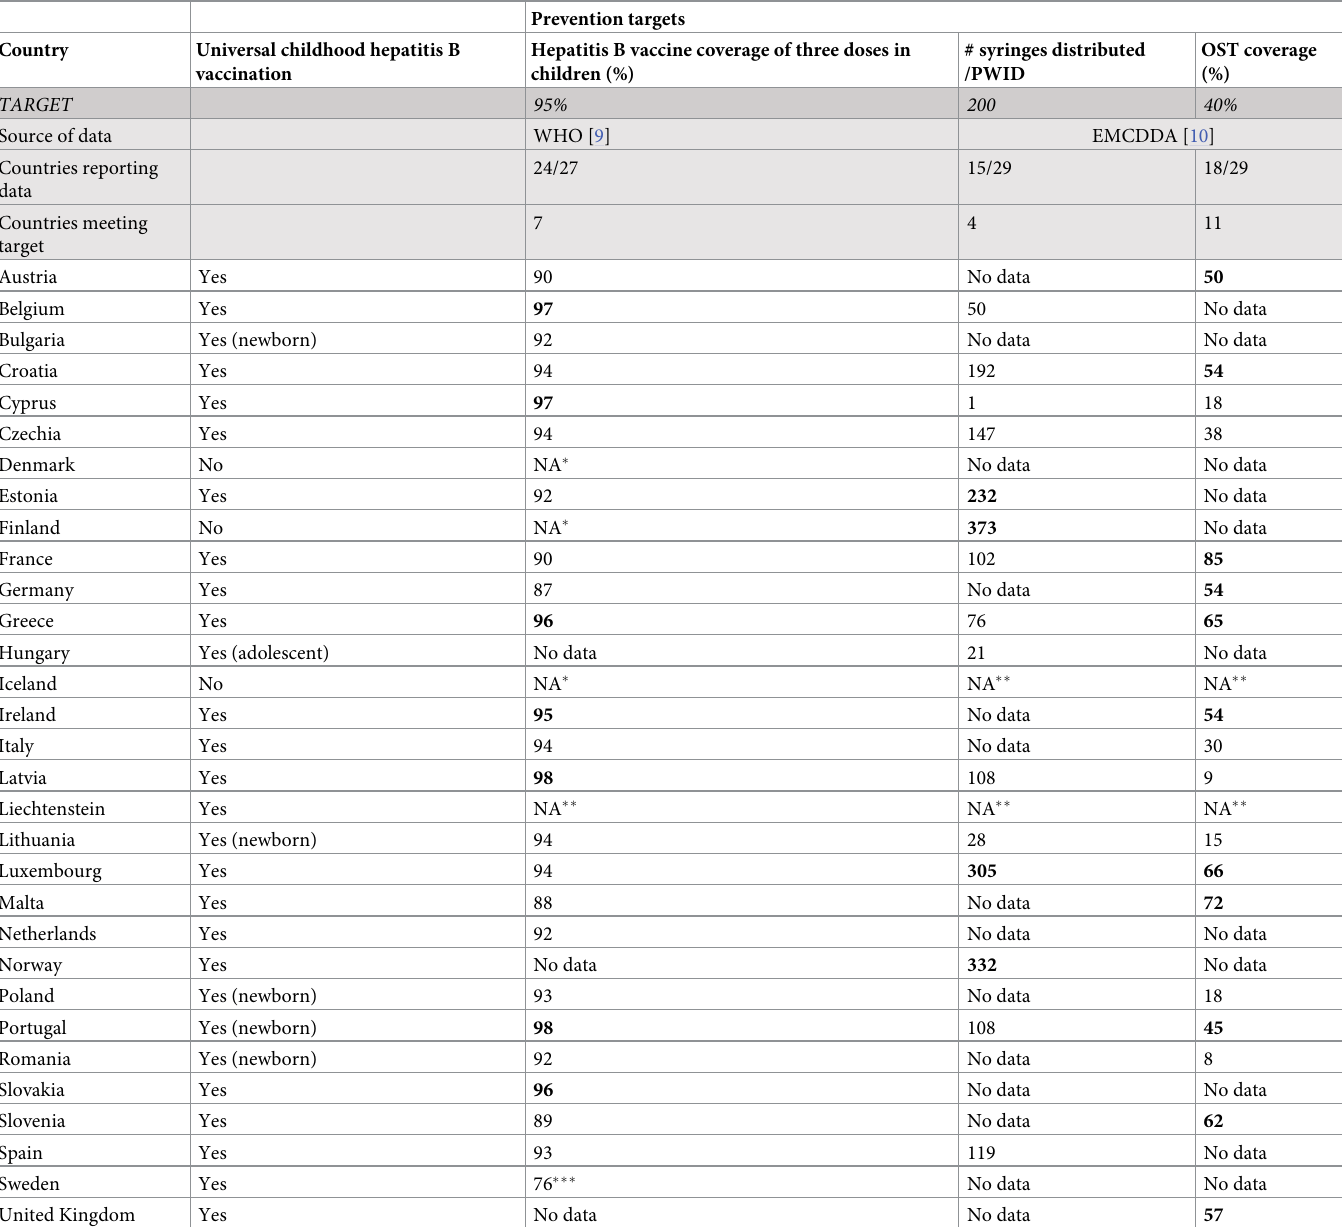
Table 2. Region and country reporting and progress towards targets for prevention of new hepatitis B and C infections in the EU/EEA and UK, 2017¥ [8] +